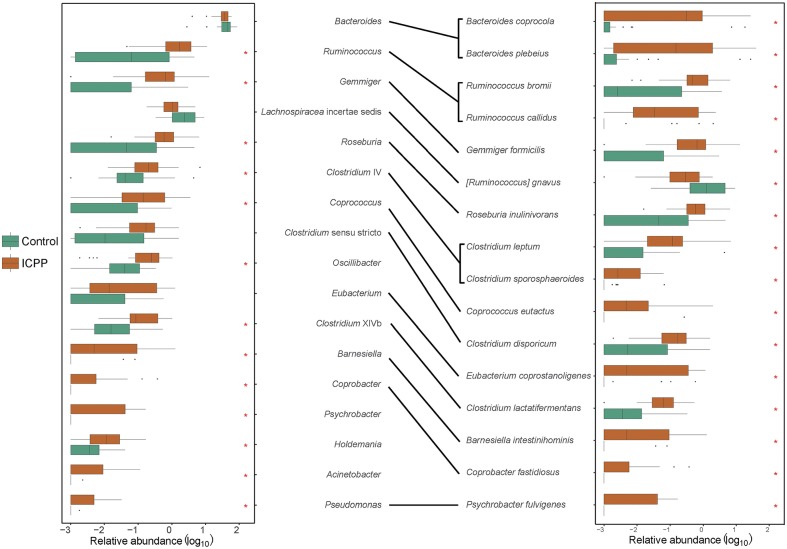
The discrepant genera and species between ICPP and Control group. Thirteen distinct genera and 16 discrepant bacterial species were found between ICPP and Control group. Most of them enriched in ICPP group. The asterisks stand for the p < 0.05.